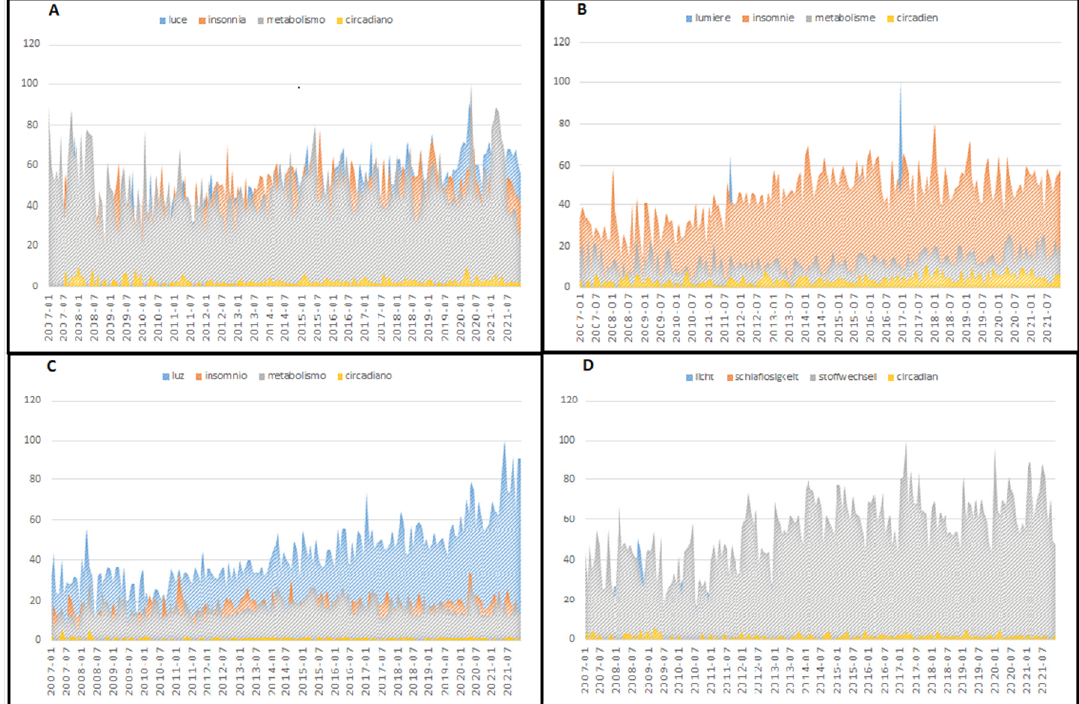
Figure 2. Variation in relative search volume associated with circadian, insomnia, light, and metabolism during each month of the study period for Italy ( A ), France ( B ), Spain ( C ), and Germany ( D ).